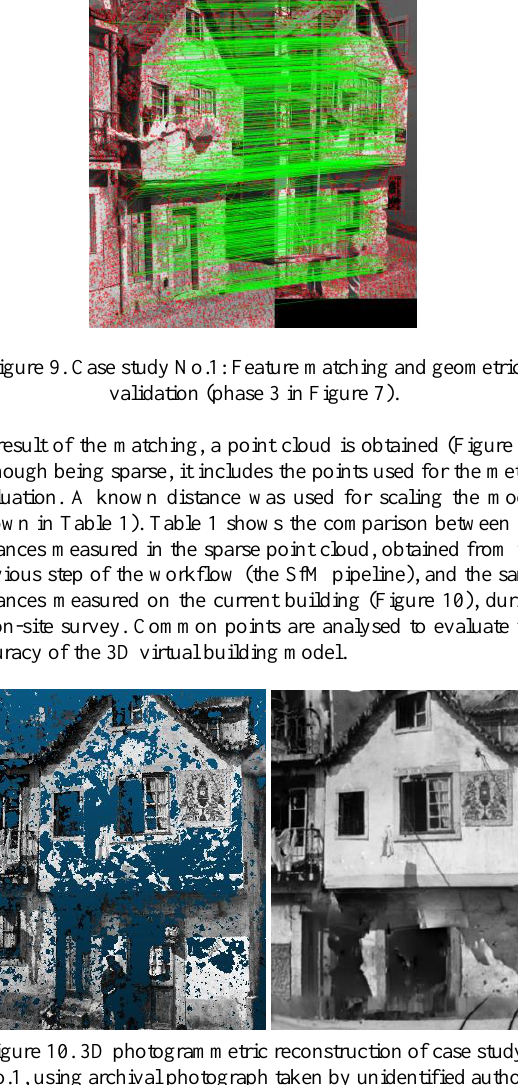
Table 1. Residuals values of the distances measured on the point cloud obtained from photographs processing and on-site survey.